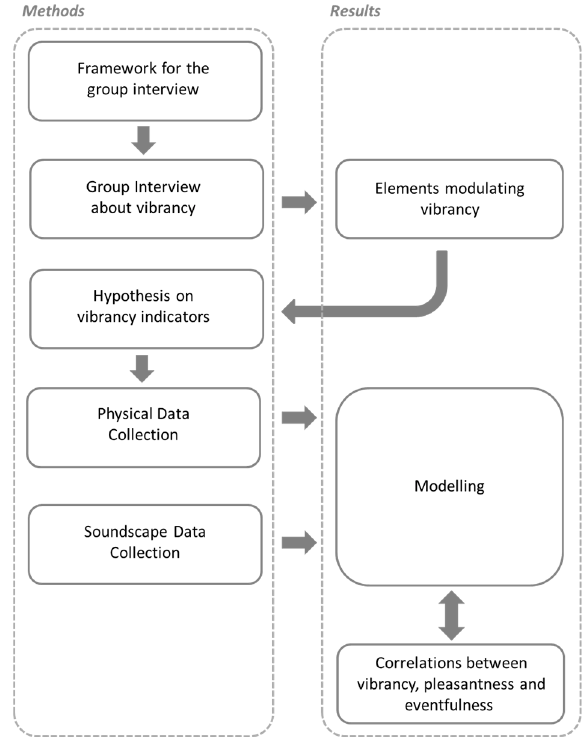
Figure 2. Schematic representation of the methodological workflow considered within the current